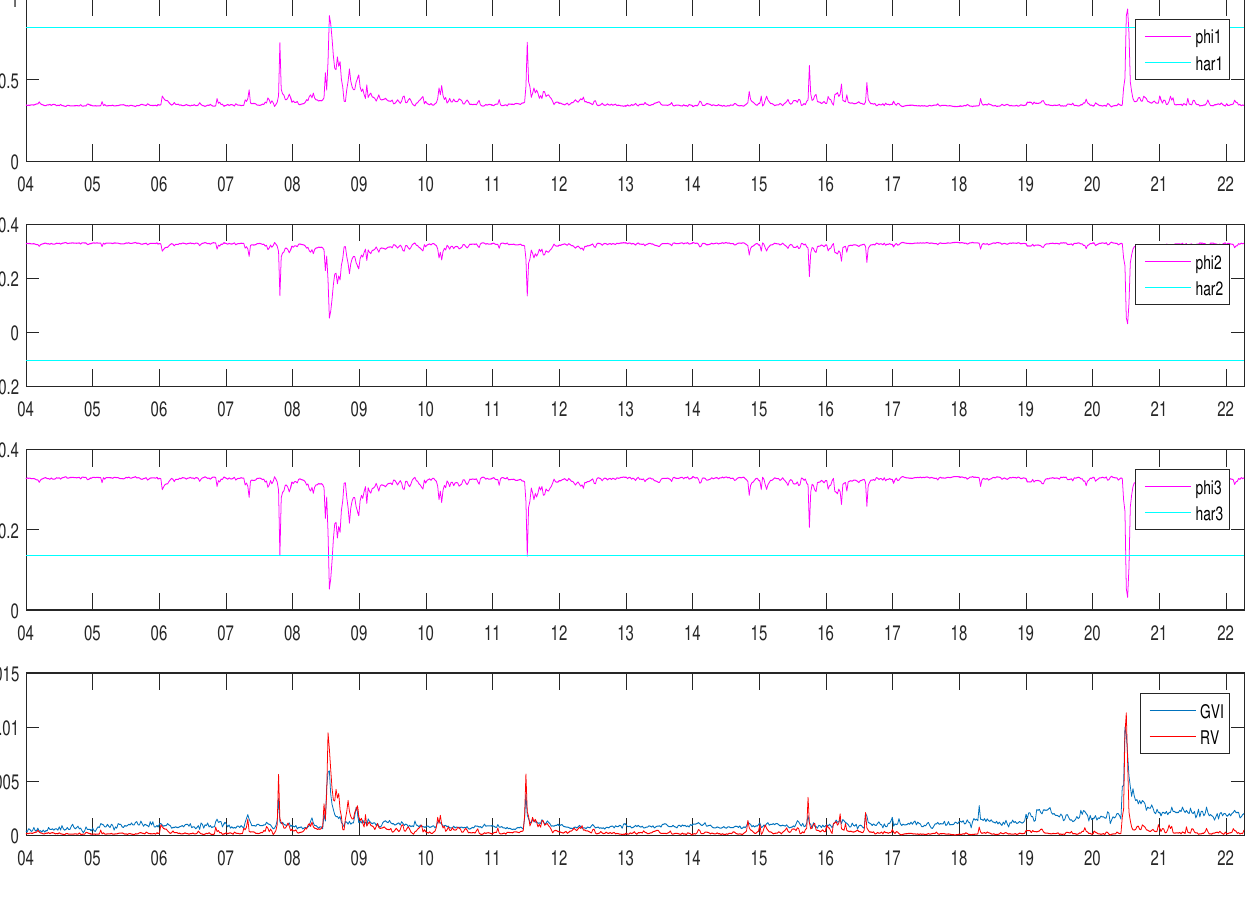
Figure 3. Time-varying empirical similarity (phi1, phi2 and phi3) under the HAR-ES model and HAR coefficient estimates (har1, har2 and har3) for the AEX index. Time-series of realized volatility and the corresponding GVI data are displayed in the bottom